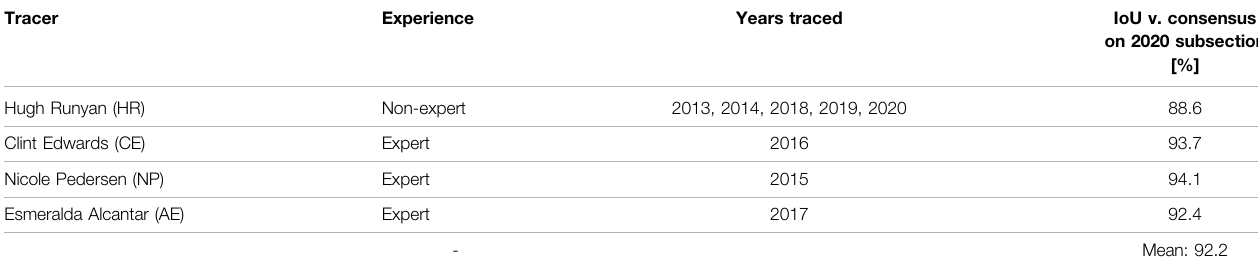
TABLE 1 | Coral segmenters, their experience, the plot(s) they traced, and IoU on the 3 m × 3 m subsection of the 2020 model relative to